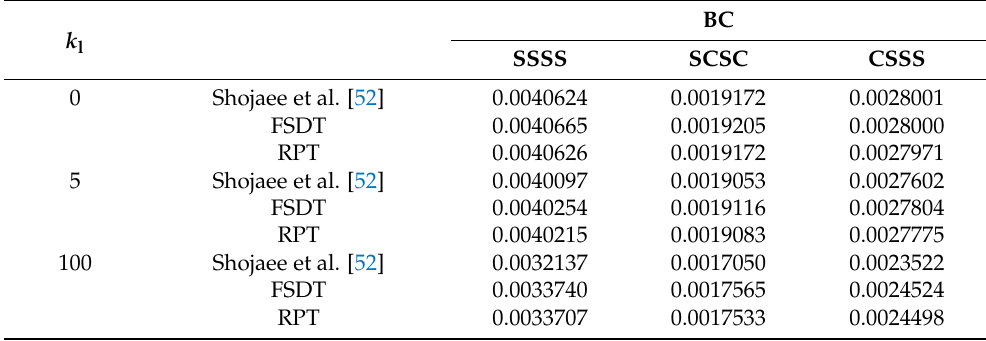
Table 2. Comparison of dimensionless central deflection of square plate on elastic foundation with different boundary conditions.